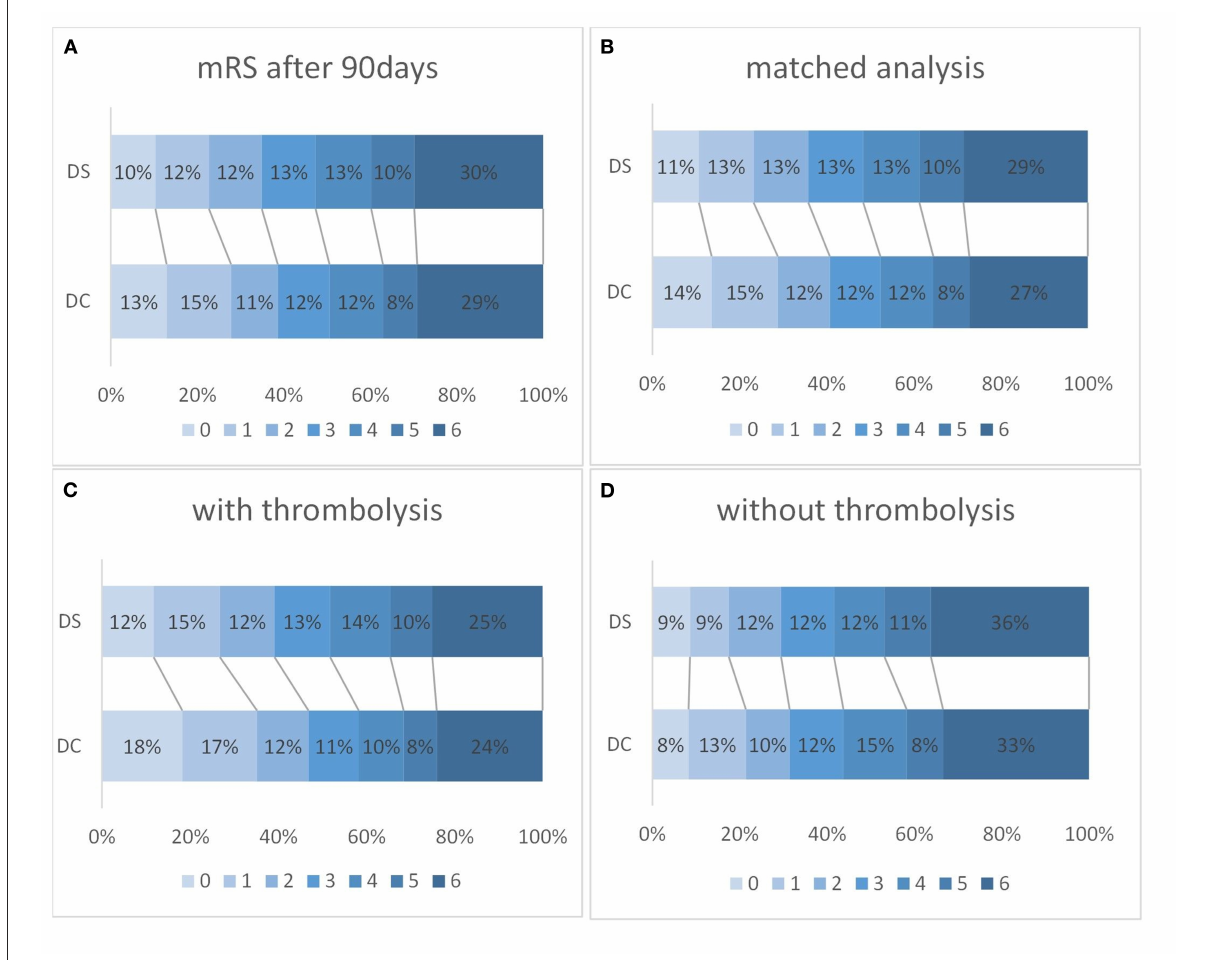
FIGURE2 The outcome on modified Rankin Scale (mRS) after 90 days for drip-and-ship (DS) and direct-to-center (DC) in all patients [ (A) ; DS n = 2,266; DC, n = 3,172; OR 1.28; 95%-CI 1.15–1.41; p < 0.001] and after a propensity score matched analysis [ (B) ; DS n = 2,114; DC n = 2,993; OR 1.28; 95%-CI 1.15–1.41; p < 0.001]. Favorable outcome (mRS 0–2) was also significantly more likely in DC than DS admissions after thrombolysis [ (C) ; DS n = 1,273, DC n = 1,485; OR 0.73; 95%-CI 0.64–0.83; p < 0.001], but not if thrombolysis was not administered [ (D) ; DS n = 977, DC n = 1,663; OR 0.87; 95%-CI 0.72–1.05; p =